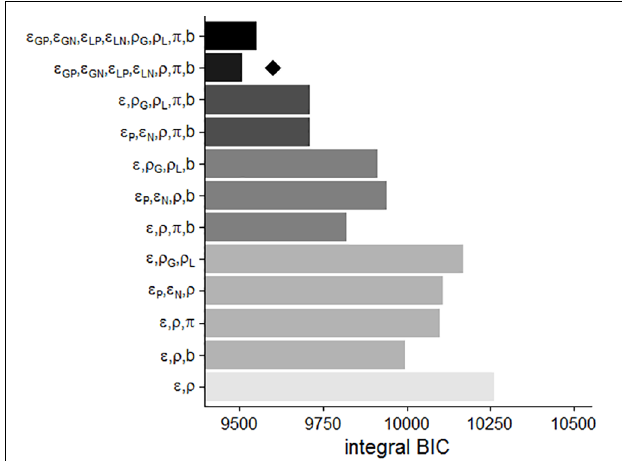
FIGURE 6 | Model comparisons in Experiment 2. ε , learning rate; ρ , subjective impact of outcomes; b, action bias; π , Pavlovian factor. The subscripts represent the following: P, positive PE; N, negative PE; G, gain domain; L, loss domain. The brightness represents the number of parameters. The diamond shape represents the winning model.